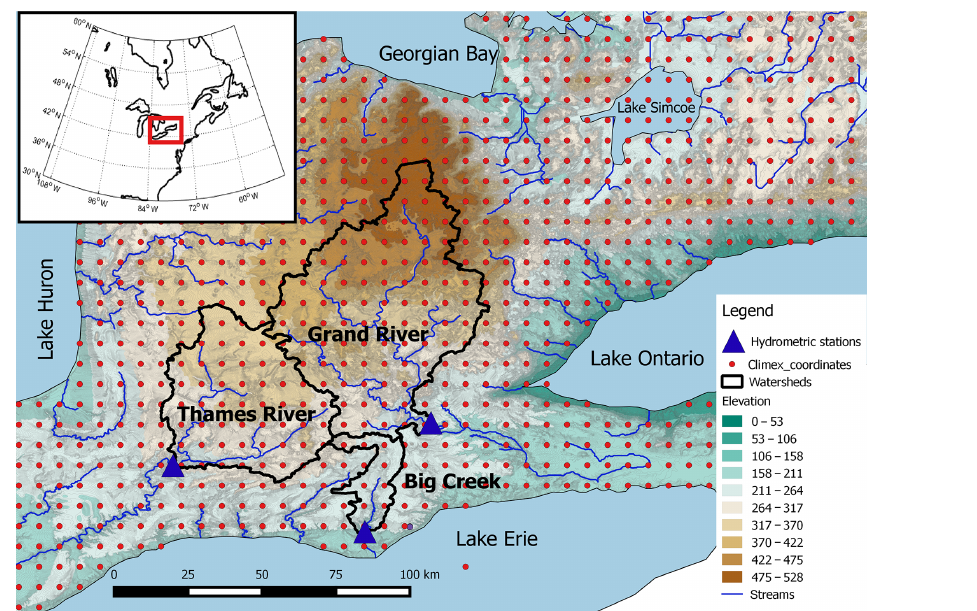
Figure 1. Location of the three watersheds and the ClimEx grid points used in this study and situation in the north-eastern North American domain (inset). Elevation source: High Resolution Digital Elevation Model (HRDEM, Natural Resources